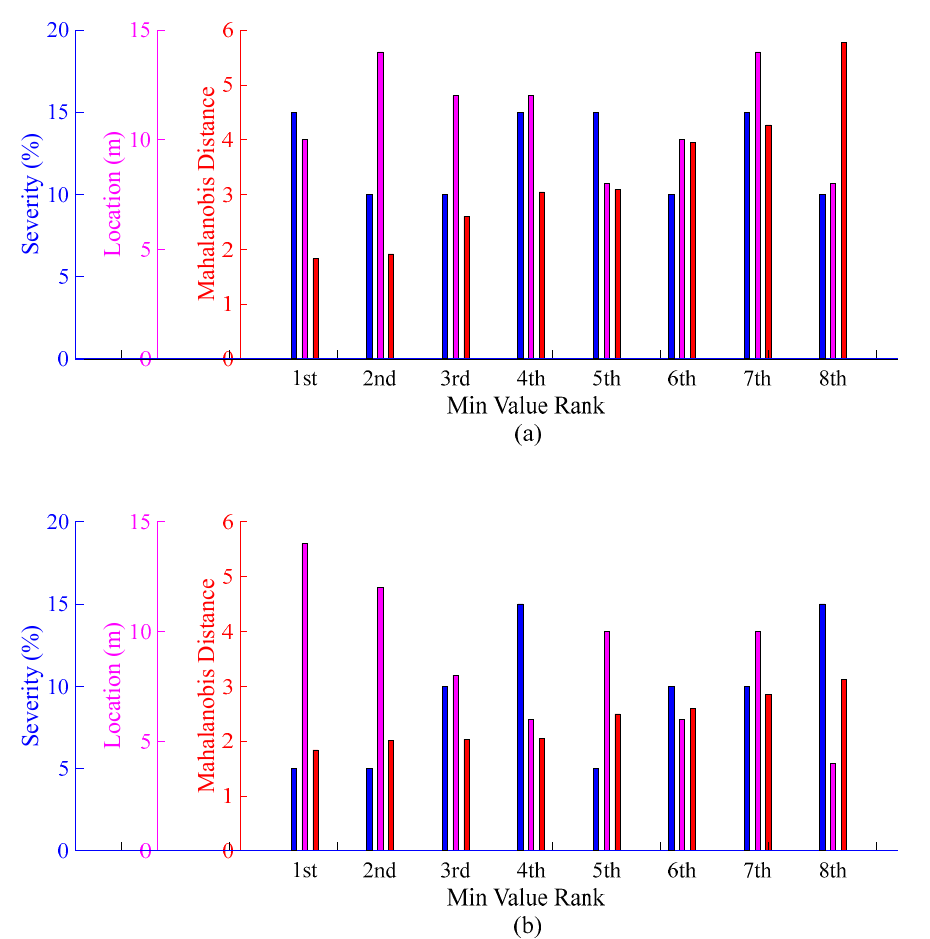
Figure 17. Min value rank of Mahalanobis distance for scenarios: ( a ) 15% crack at 10 m, and ( b ) 5% crack at 14 m.